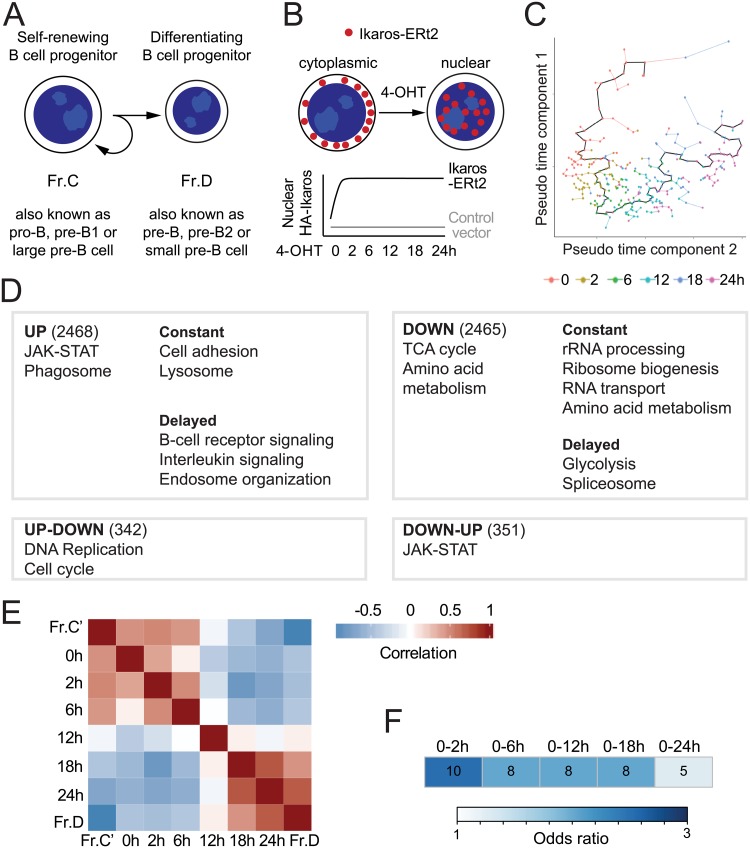
An Ikaros-driven in vitro system captures key features of in vivo B cell progenitor differentiation.(A) Schematic representation of self-renewing (left) and differentiating (right) B cell progenitors and the nomenclature used to refer to these populations in the literature. (B) Experimental design of Ikaros-induced B3 cell differentiation. RNA-seq was performed at the indicated time points. The experiment was designed so that sources of variability could be traced to library preparation and sequencing biases and corrected (see Methods). Effects of 4-OHT were monitored by addition of 4-OHT to control vector cells and found to be negligible. (C) Pseudotemporal ordering of cells as a function of their scRNA-seq transcriptomes. The pseudotime trajectory is shown in black. (D) Gene set analysis of gene expression trends in B3 differentiation. Each box contains the total number of genes and the major functional terms (q < 0.01) for each of 4 expression trends (up-regulated, down-regulated, first up- then down-regulated, and first down- then up-regulated). Up- and down-regulated trends are further separated into 2 subtrends, constant and delayed. (E) Comparison of the transcriptomes of the B3 in vitro differentiation time course with in vivo B cell progenitor differentiation stages. The 0 to 6 h time points resemble Fr.C, whereas 18 and 24 h are similar to Fr.D, and the 12 h time point represents a tipping point. The source of the numerical data underlying this figure is listed in S1 Data. (F) Comparison of genes differentially expressed in IKZF1 mutated human B-ALL and the B3 differentiation. Numbers denote common genes that are differentially expressed in IKZF1-mutated versus IKZF1 wild-type human B-ALL and the top 200 genes regulated at the indicated times after Ikaros induction in B3 cells. The color scale indicates the odds ratio for the enrichment of Ikaros-regulated gene during B3 cell differentiation among differentially expressed genes in human B-ALL with and without IKZF1 mutations. B-ALL, B cell progenitor acute lymphoblastic leukemia; ERt2; Fr.C, proliferating B cell progenitor; Fr.D, differentiating B cell progenitor; HA, haemagglutinin; JAK-STAT, Janus kinase/signal transducers and activators of transcription; RNA-seq, RNA sequencing; scRNA-seq, single cell RNA sequencing; TCA, tricarboxylic acid cycle; 4-OHT, 4-hydroxy-tamoxifen.